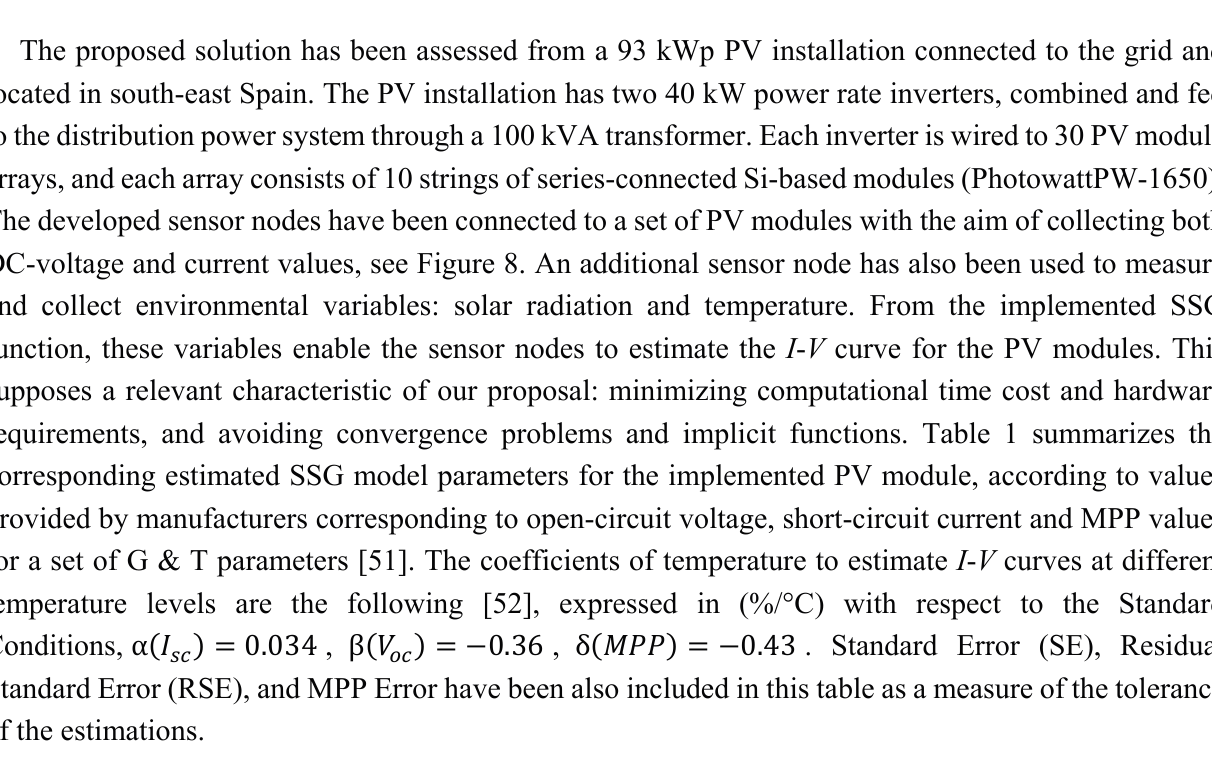
Table 1. Estimated Symmetrized Shifted Gompertz (SSG) Model